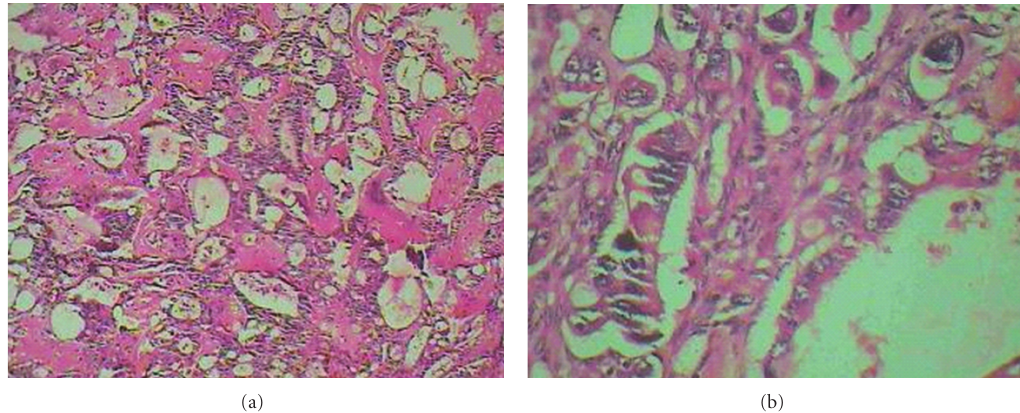
Figure 3: Histopathological section of metastatic tumor. (a) Low power field: the tumor infiltrated bone as atypical glands. (b) High power field: atypical gastric glands lined by pleomorphic hyperchromatic tumor cells.